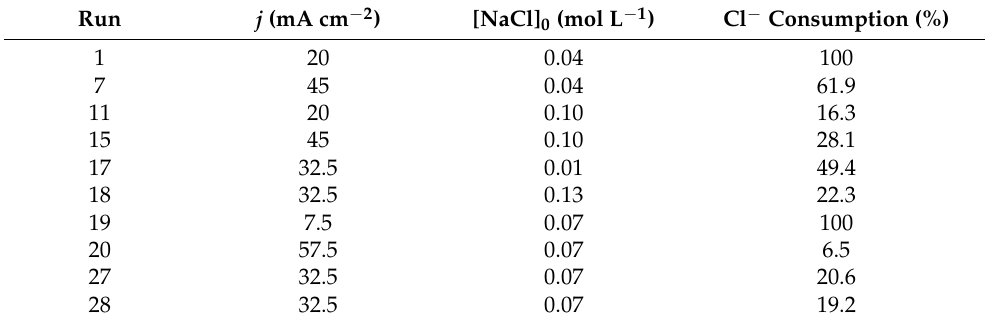
Table 6. Consumption of chloride anions after 20 min of anodic oxidation for selected experiments.